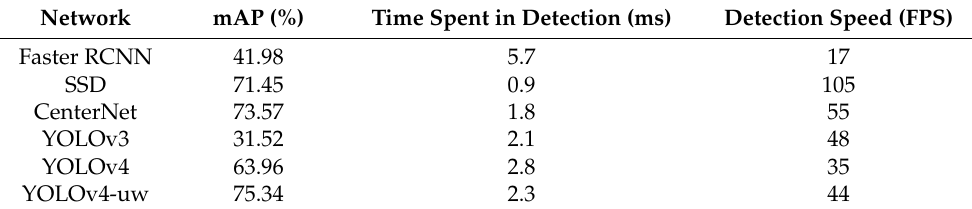
Table 3. Comparison between YOLOv4-uw and other networks.